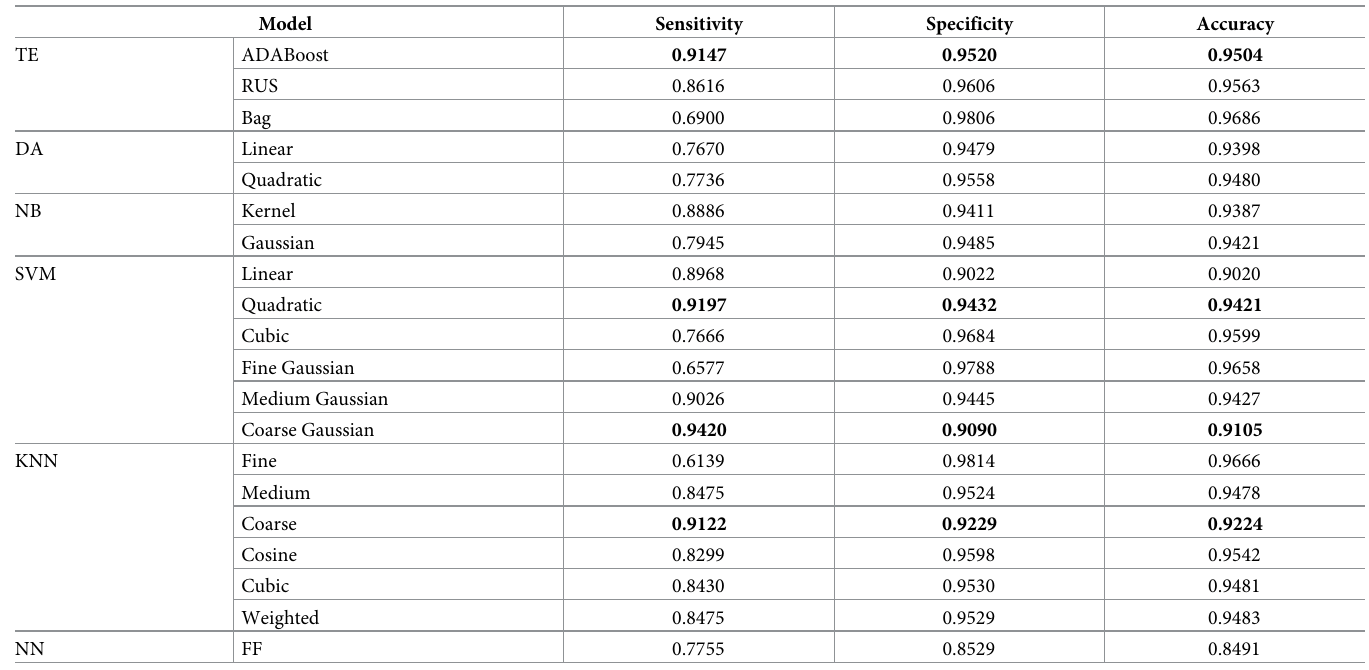
Table 1. Performance of different classifiers in detecting drops in